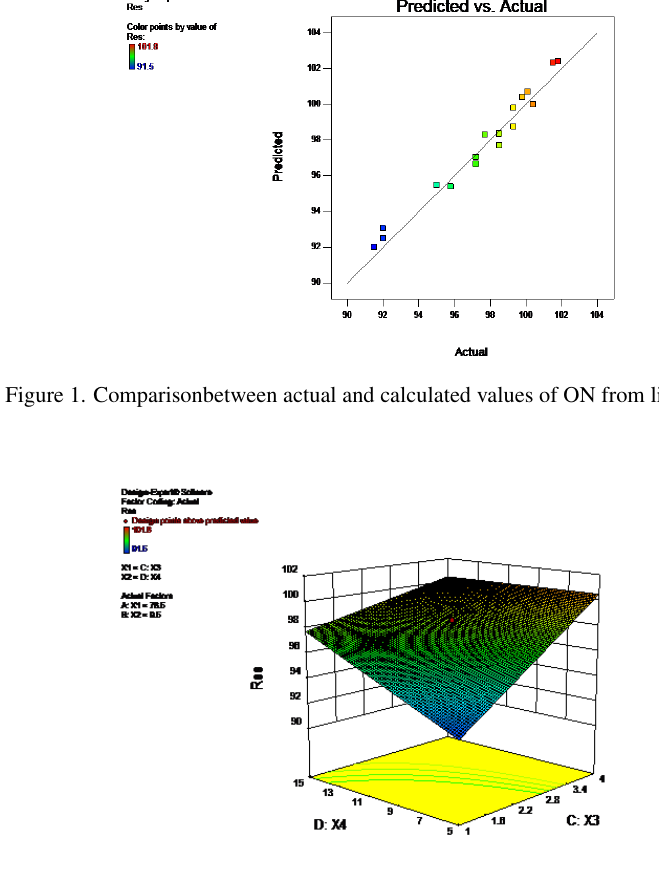
Figure 2. ONvariation as function of variables X3 and X4 for linear model